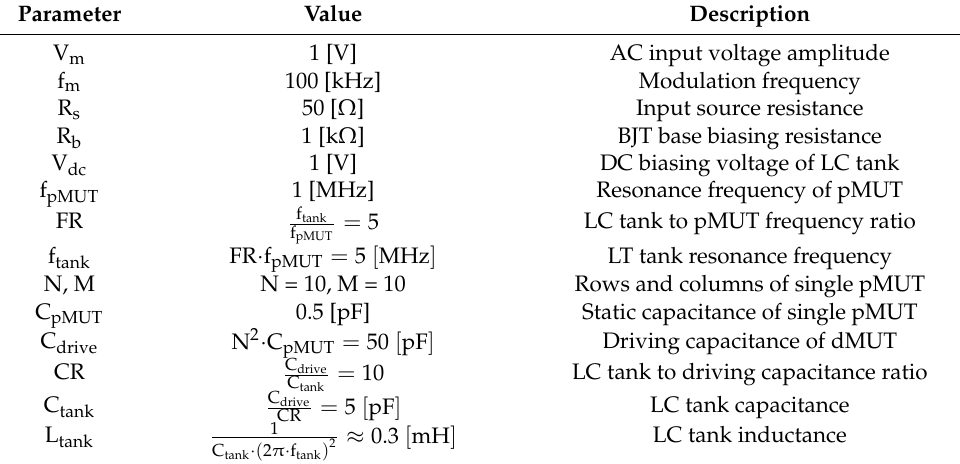
Table 1. Parameters summary of the dMUT system together with their typical values (unless otherwise specified in the paper) and their description.